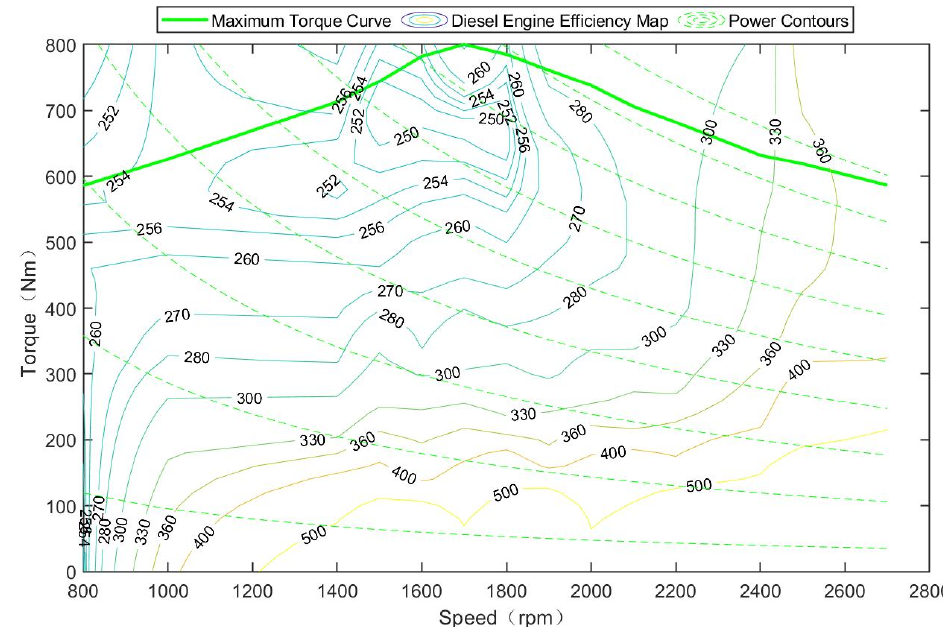
Figure 3. Diesel engine model MAP diagram.